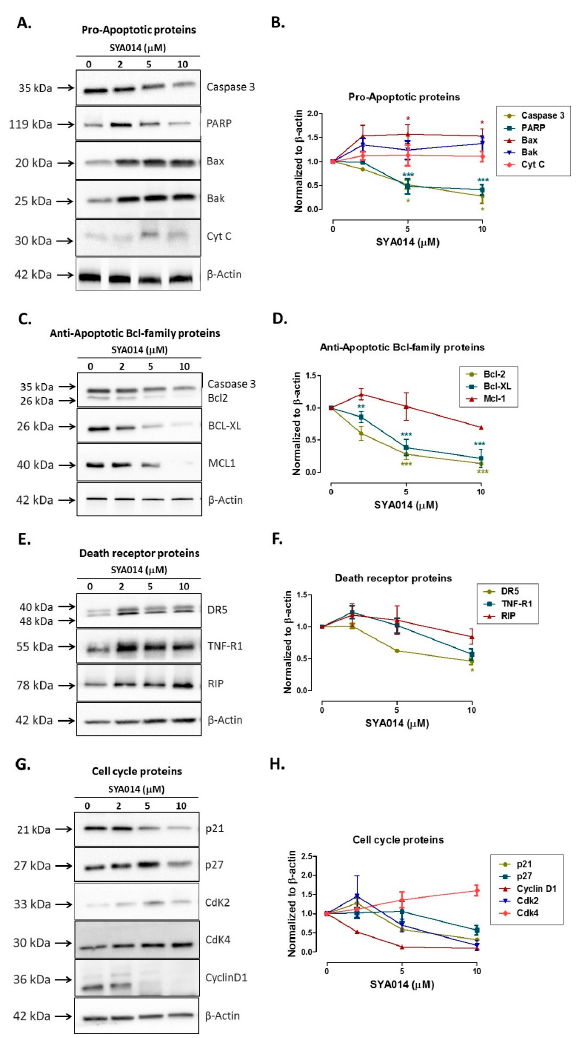
Figure 9. Effect of SYA014 on pro-apoptotic ( A , B ), anti-apoptotic ( C , D ), death receptor proteins ( E , F ), and cell cycle proteins ( G , H ). Western blot analyses shows that SYA014 activates the Bcl-2 family pro-apoptotic proteins and antagonizes Bcl-2 family pro-survival proteins in MDA-MB-231 cells. Cells were treated for 48 h and lysed. Aliquots of lysates containing 50 µ g of protein were analyzed by western blot, probing with the respective antibodies followed by chemiluminescent detection. β -actin was used as the internal control. Figure S2: Original western blot images. * p < 0.05, ** p < 0.01, and *** p <